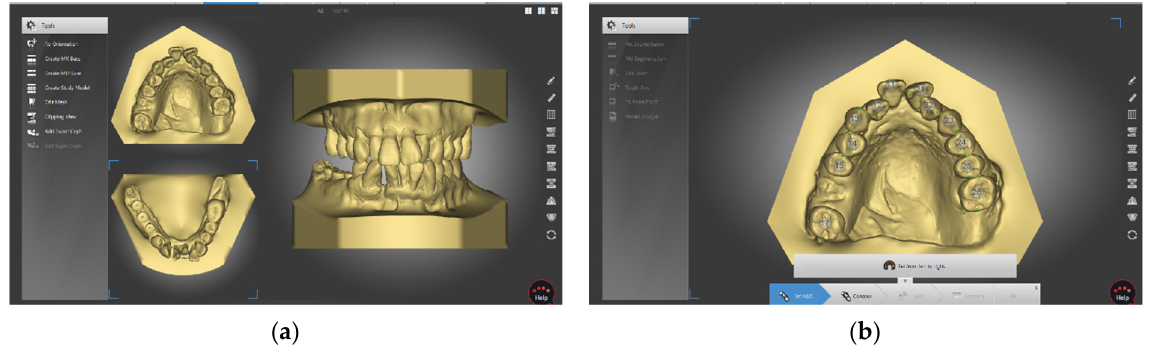
Figure 4. ( a ) The screen where the digital model is loaded into the setup program. One can see the dentition of the upper and lower jaws and the patient’s current occlusion status. ( b ) A photograph showing the most mesial and distal parts of each tooth with green dots after each tooth marked to distinguish and display the teeth in the digital model.